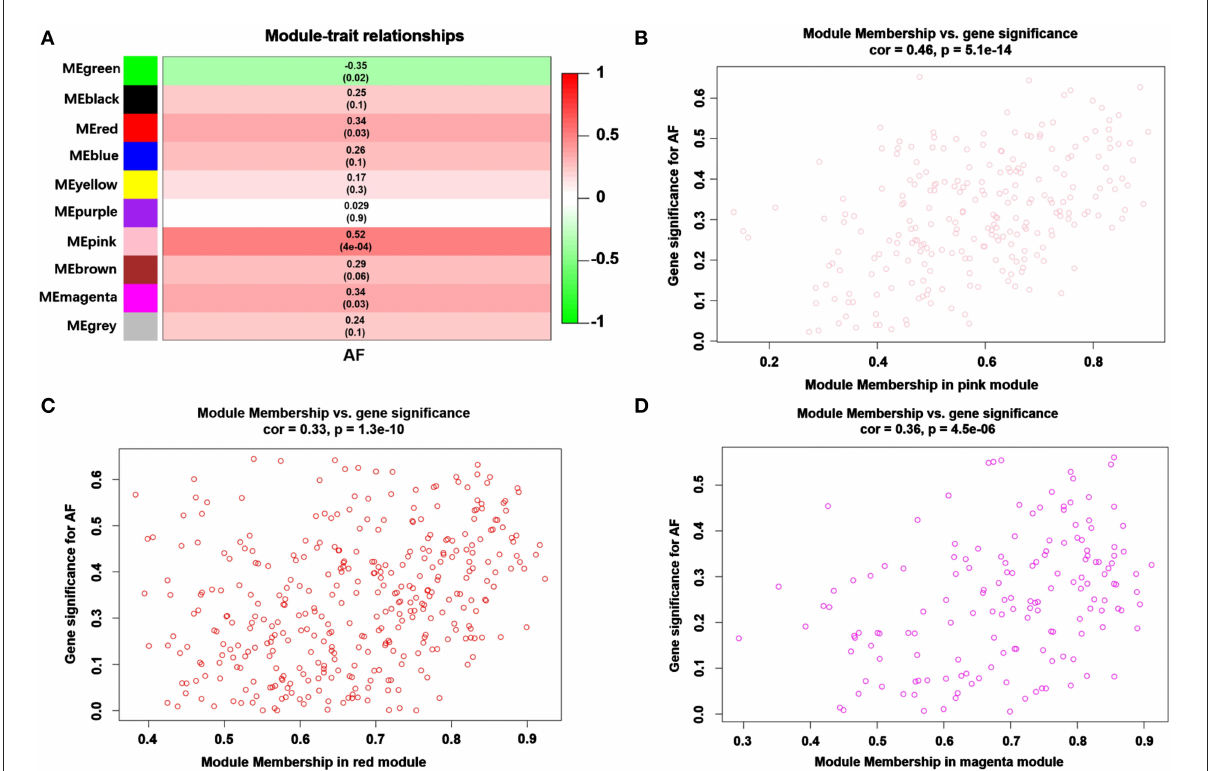
FIGURE2 Module-feature associations and associations between gene significance and module membership (MM). (A) The module genes are listed in each row, and the clinical phenotype is listed in each column. The correlations and the p values for listed genes and clinical phenotypes are shown in each cell. The different correlations are represented as different colors. A representative scatter plot displays the correlations between MM and GS vs. module membership (MM) of AF in the pink (B) , red (C) and magenta (D) modules.